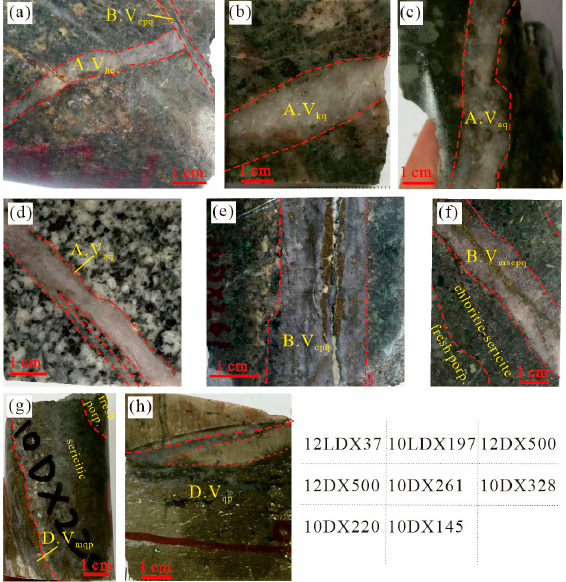
Figure 5. Hydrothermal vein types recognized in the Tongchang porphyry Cu deposit. ( a ) An A-type hematite quartz vein in the granodiorite porphyry (A.V hq ), crosscut by a B-type chalcopyrite pyrite quartz vein (B.V cpq ); ( b ) An A-type K-feldspar quartz vein in the granodiorite porphyry (A.V kq ); ( c , d ) A-type anhydrite quartz veins in the granodiorite porphyry (A.V aq ); ( e ) A B-type chalcopyrite pyrite quartz vein in the granodiorite porphyry (B.V cpq ); ( f ) A B-type molybdenite anhydrite chalcopyrite pyrite quartz vein in the granodiorite porphyry (B.V macpq ) with chlorite-sericite halos; ( g ) A D-type quartz pyrite vein in the granodiorite porphyry with sericitic halo (D.V qp ); ( h ) A D-type pyrite-dominated veins (D.V pd ) in phyllite. Two B subtype veins have been selected, including chalcopyrite-pyrite-quartz (B.V cpq ) and molybdenite-anhydrite-chalcopyrite-pyrite quartz vein (B.V macpq ). They are characterized by centerlines of sulfides and straight vein boundaries without alteration halos. B.V cpq veins consist of about 70–90% quartz and 10–30% sulfides, with variable py- rite to chalcopyrite ratios (Figure 5e). B.V macpq veins differ from B.V cpq veins with addi- tional molybdenite and anhydrite in the vein and chloritic alteration halos. They com- monly consist of about 70% quartz, 10% pyrite, 5–10% chalcopyrite, 5% anhydrite and minor amounts of molybdenite (Figure 5f). B.V cpq and B.V macpq crosscut B.V hq veins but no other crosscutting relations have been observed between B subtypes.